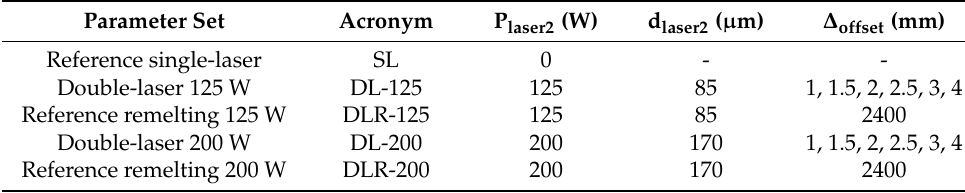
Table 3. Overview of parameter sets for the specimen manufacturing.